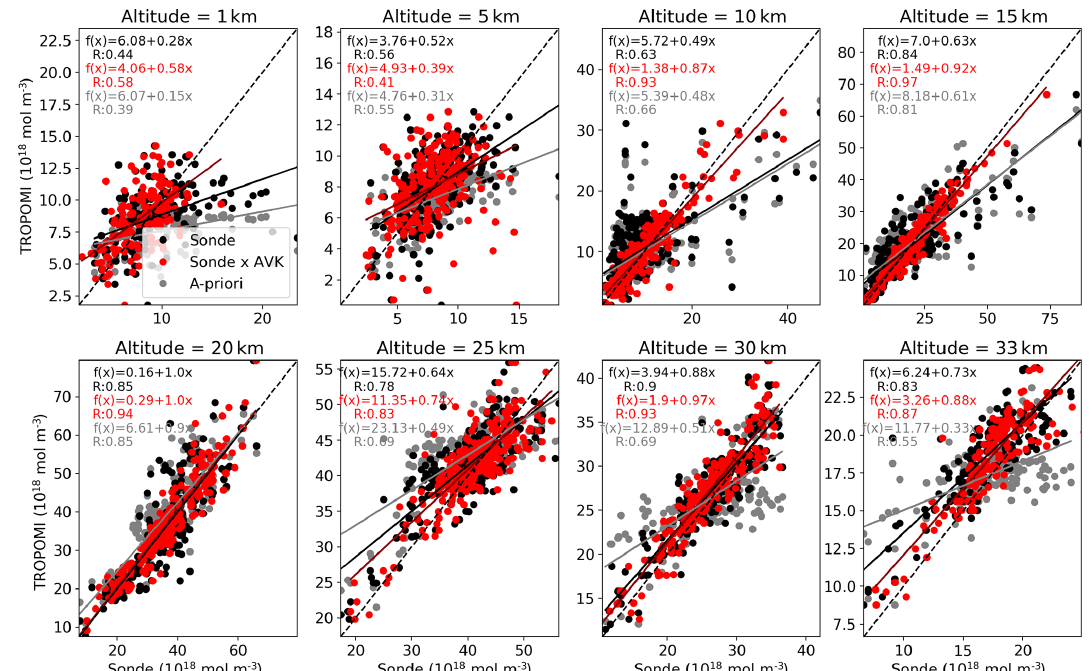
Figure 8. Scatter plot of collocated TROPOMI and ozonesonde profiles, the latter with and without convolving with TOPAS averaging kernels (red and black, respectively) for different altitudes (note different scales). The comparison between a priori and sonde profiles is shown in grey. The solid lines show the linear fit. The R value is indicated in the top left corner of each panel (also black and red). The ideal 1 : 1 curve is plotted as a dashed